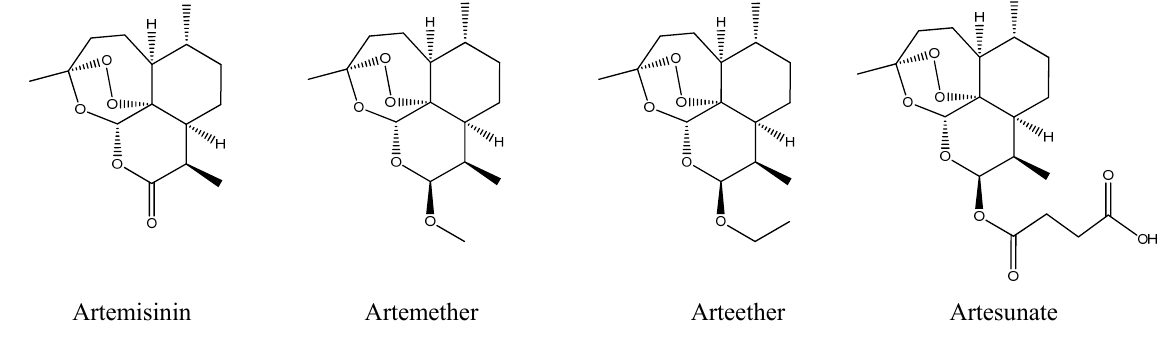
Figure 1. Artemisinin and its semi-synthetic derivatives, which are currently used in the treatment of